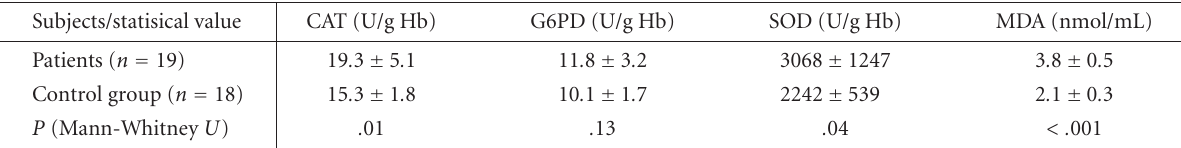
Table 3. The mean values of catalase (CAT), glucose-6-phosphate dehydrogenase (G6PD), and superoxide dismutase (SOD) activities and malondialdehyde (MDA) levels in adult subgroups in both groups (mean ± standard deviation). Subjects/statisical